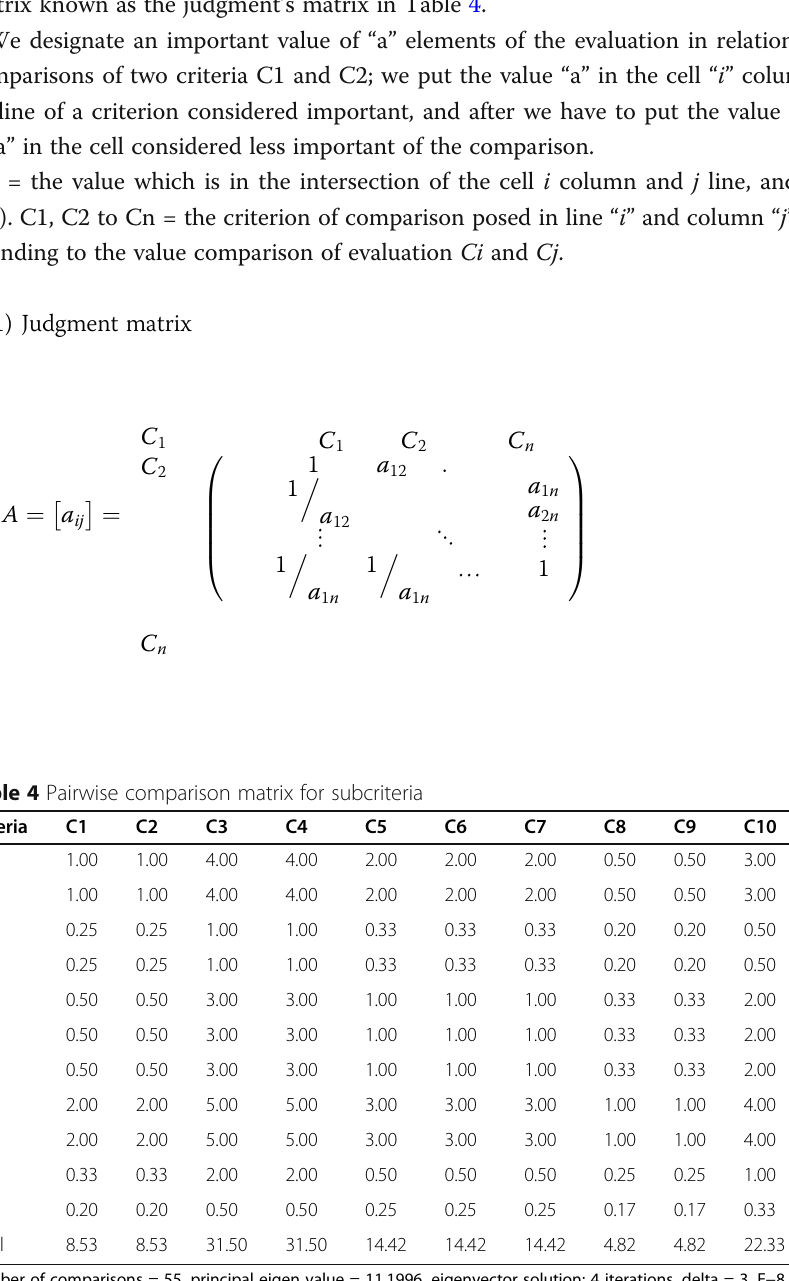
Number of comparisons = 55, principal eigen value = 11,1996, eigenvector solution: 4 iterations, delta = 3, E −